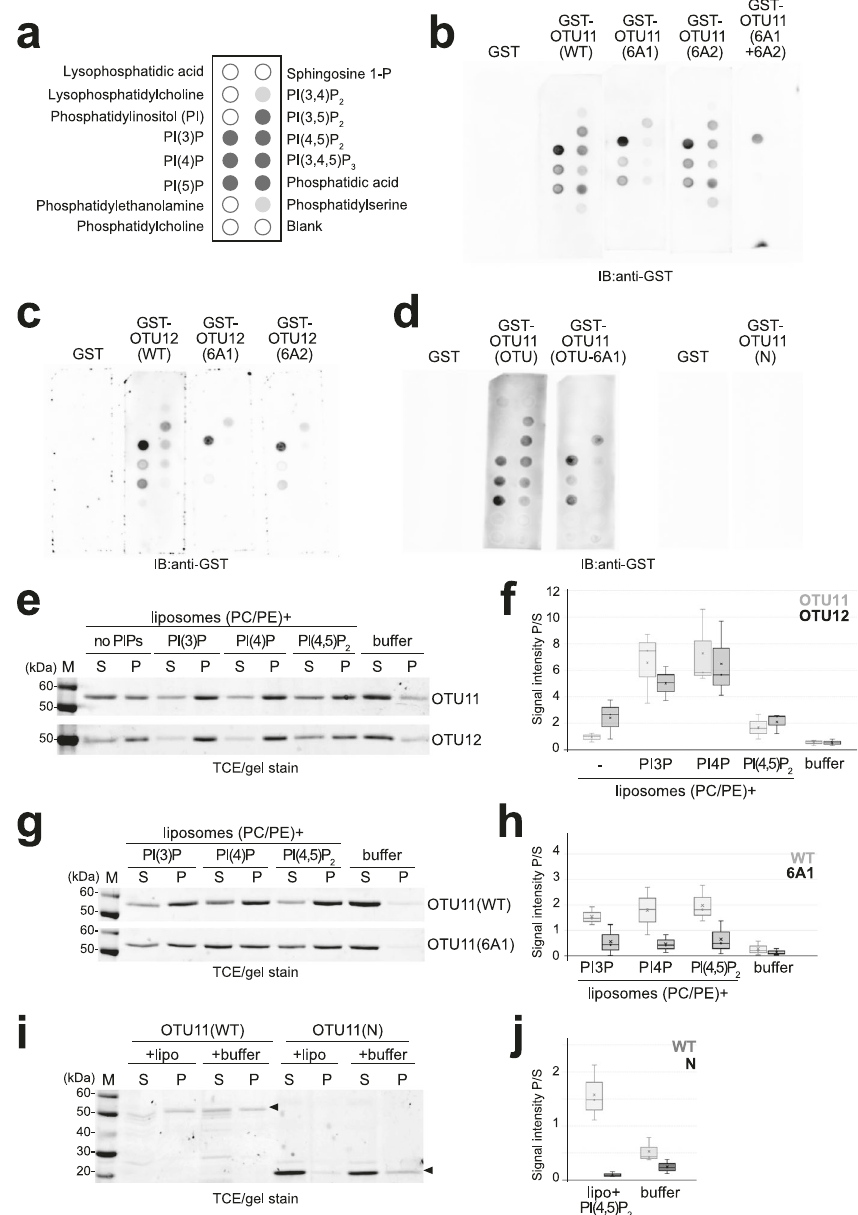
Fig. 6 | PBMs in OTU11 and OTU12 are required for their interaction with anionic lipids in vitro. a Lipid species spotted on the membrane for the lipid overlay assay. The solid dark gray and light gray spots indicate lipids that showed interactions in the lipid-overlay assays. b – d Lipid overlay assays with GST, GST- OTU11(WT), GST-OTU11(6A1), GST-OTU11(6A2), and GST-OTU11(6A1+6A2) ( b ), GST, GST-OTU12(WT), GST-OTU12(6A1), and GST-OTU12(6A2) ( c ) and GST, GST- OTU11(OTU), GST-OTU11(OTU-6A1), and GST-OTU11(N) ( d ). Bound proteins were detected with an anti-GST antibody. e Representative gel images of liposome sedimentation assays using GST-OTU11(WT) and GST-OTU12(WT). GST-fusion proteinswereincubatedwiththe liposome bufferaloneorwithliposomes(PC/PE) containing no PIPs or 5% of one of PI(3)P, PI(4)P, or PI(4,5)P 2 . SDS-PAGE gels were stained with TCE. M molecular mass marker. f Quanti fi cation of the result in ( e ). The signal intensity of the protein band in the pellet fraction was divided by the signal intensity of the protein band in the supernatant fraction for each lane to calculate the intensity ratio of pellet/supernatant (P/S). Box plot shows the results of the quanti fi cation of at least three independent experiments. Center line,